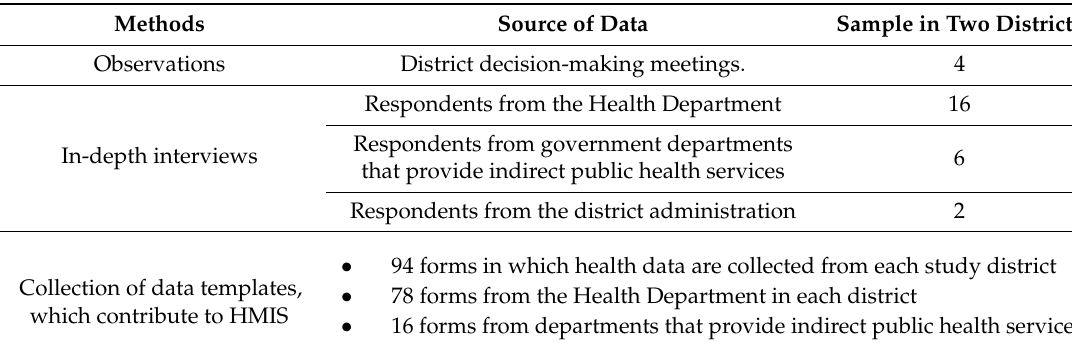
Table 1. Data collection